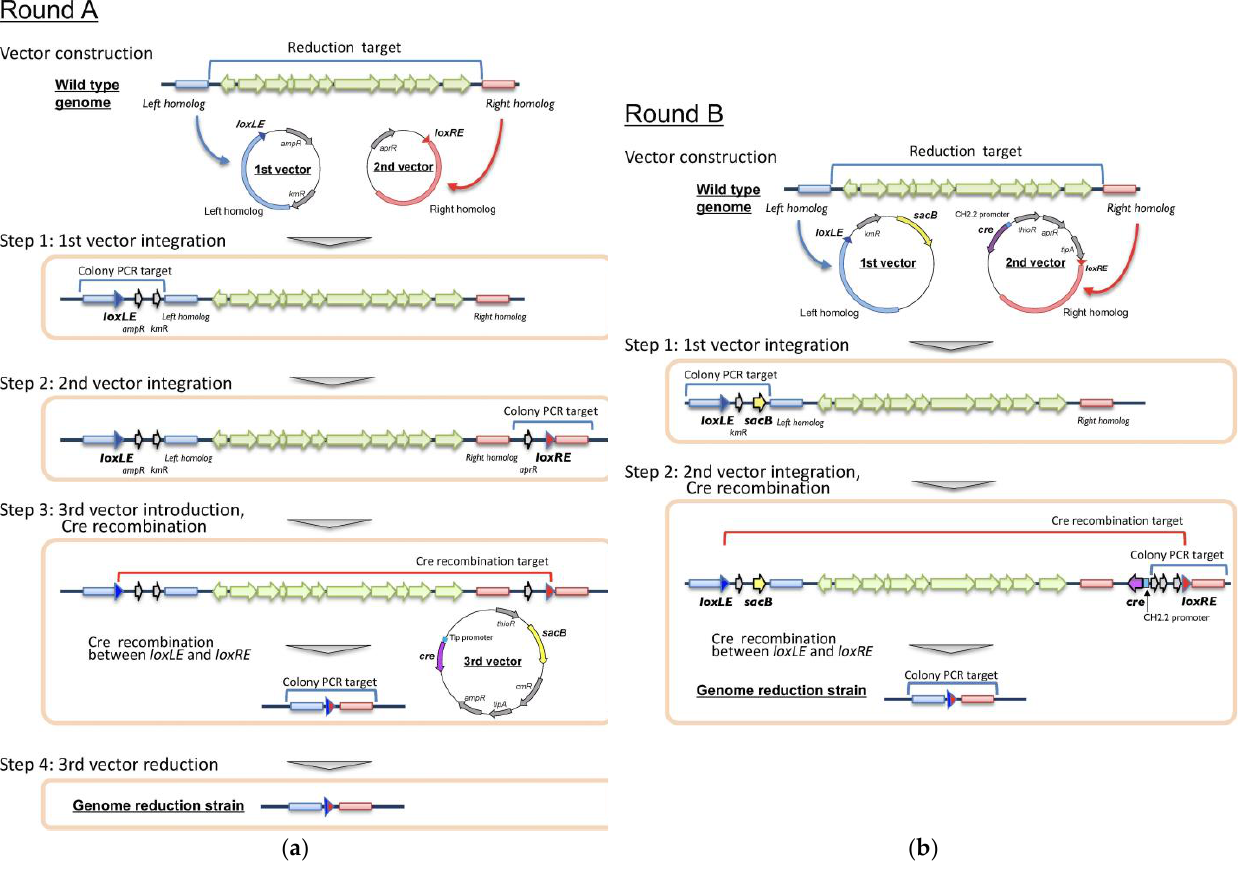
Figure 2. Large-size genome-reduction method using Cre/ loxP . ( a ) Four-step procedure requires three plasmid-introduction and one plasmid-reduction steps (Round A). ( b ) Two-step procedure requires only two plasmid-introduction steps (Round B). See details in the text.